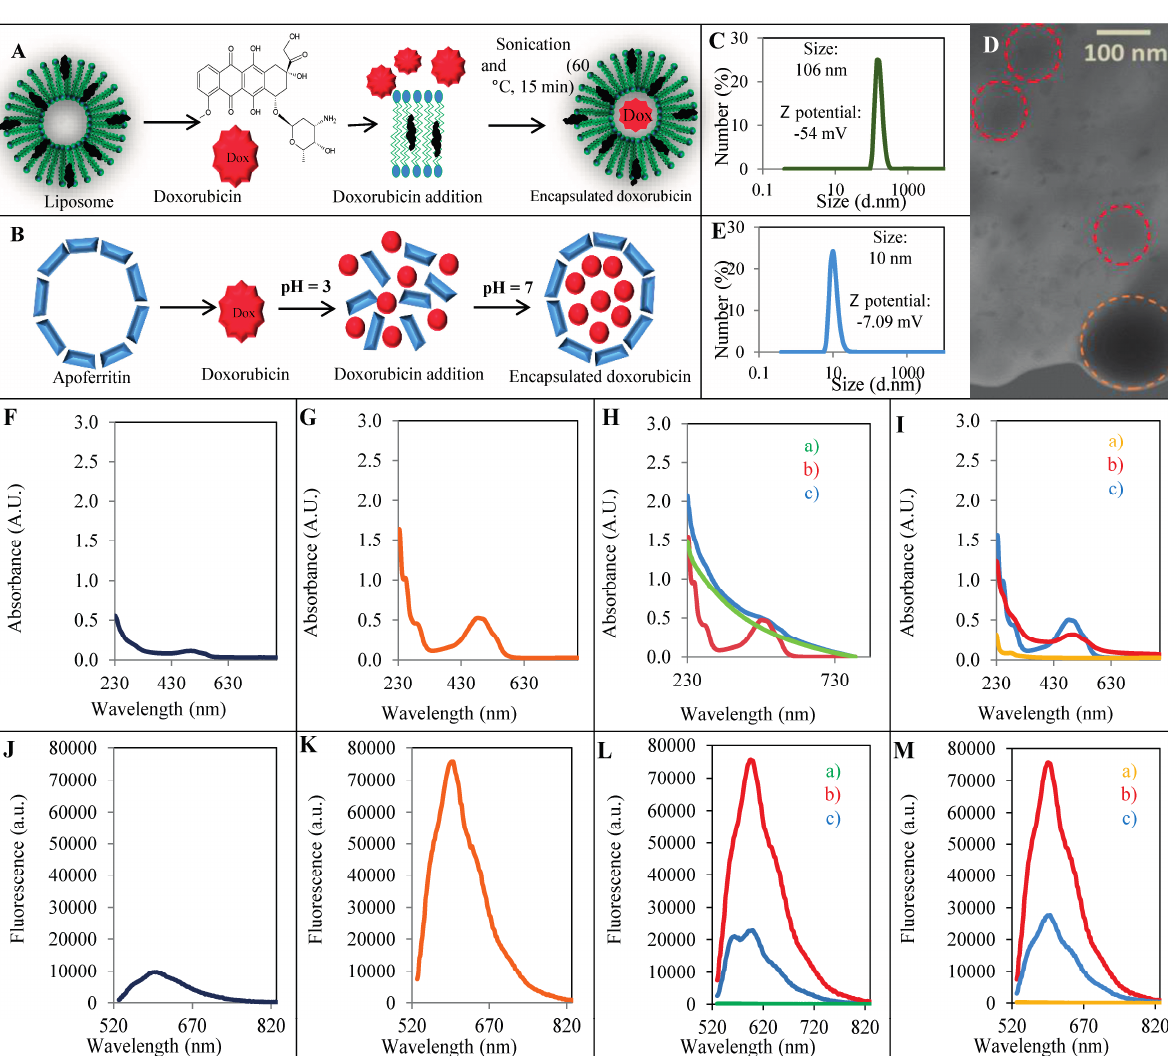
Figure 1. Scheme of encapsulation of doxorubicin into ( A ) the liposome modified by cholesterol and ( B ) apoferritin. ( C ) Size distribution of liposome and ( D ) microphotography of liposomes. Liposomes are highlighted with a circle (red circle = 100 nm and orange circle = 200 nm); ( E ) Size distribution of apoferritin. Absorbtion spectra in the range 230–800 nm of ( F ) 100 µg/mL Myocet; ( G ) Epirubicin; ( H ) Liposome (a), Doxorubicin (b), Encapsulated Doxorubicin into the liposome (c); ( I ) Apoferritin (a), Doxorubicin (b), Encapsulated Doxorubicin into the apoferritin (c); Emission spectra in the range 520–820 nm of ( J ) 100 µg/mL Myocet; ( K ) Epirubicin; ( L ) Liposome (a), Doxorubicin (b), Encapsulated Doxorubicin into the liposome (c); ( M ) Apoferritin (a), Doxorubicin (b), Encapsulated Doxorubicin into the apoferritin (c). The excitation wavelength was 510